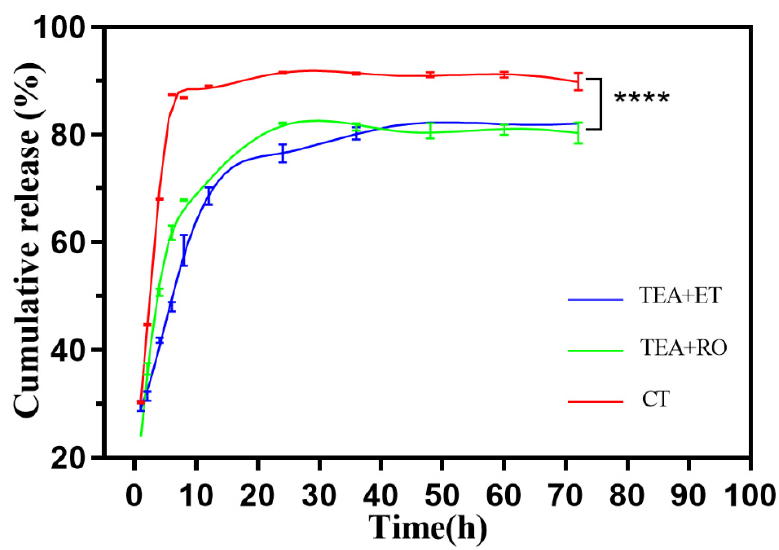
Figure 5. Drug release profile of IBU-loaded HAP in PBS ( n = 3) (**** p < 0.0001).